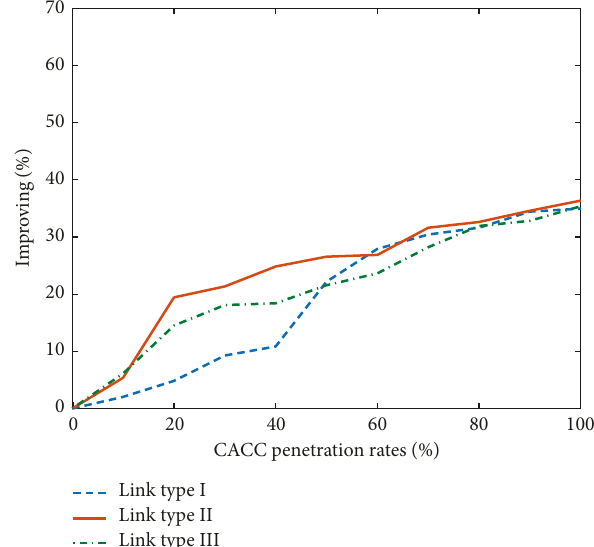
Figure 3: Comparison among CACC link types under 1200veh/hr flow.